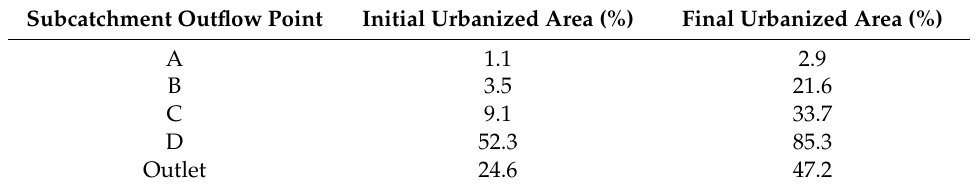
Figure 4. Percent of land area in each subcatchment that was classified as urbanized in 1992 and 2011. Locations of outflow points used in hydrologic modeling are shown. Table 6. Change in urbanized land area for subcatchments of watershed U1 analyzed with hydrologic modeling. Initial urbanized area is from NLCD 1992. Final urbanized area is from NLCD 2011. Outlet represents the whole